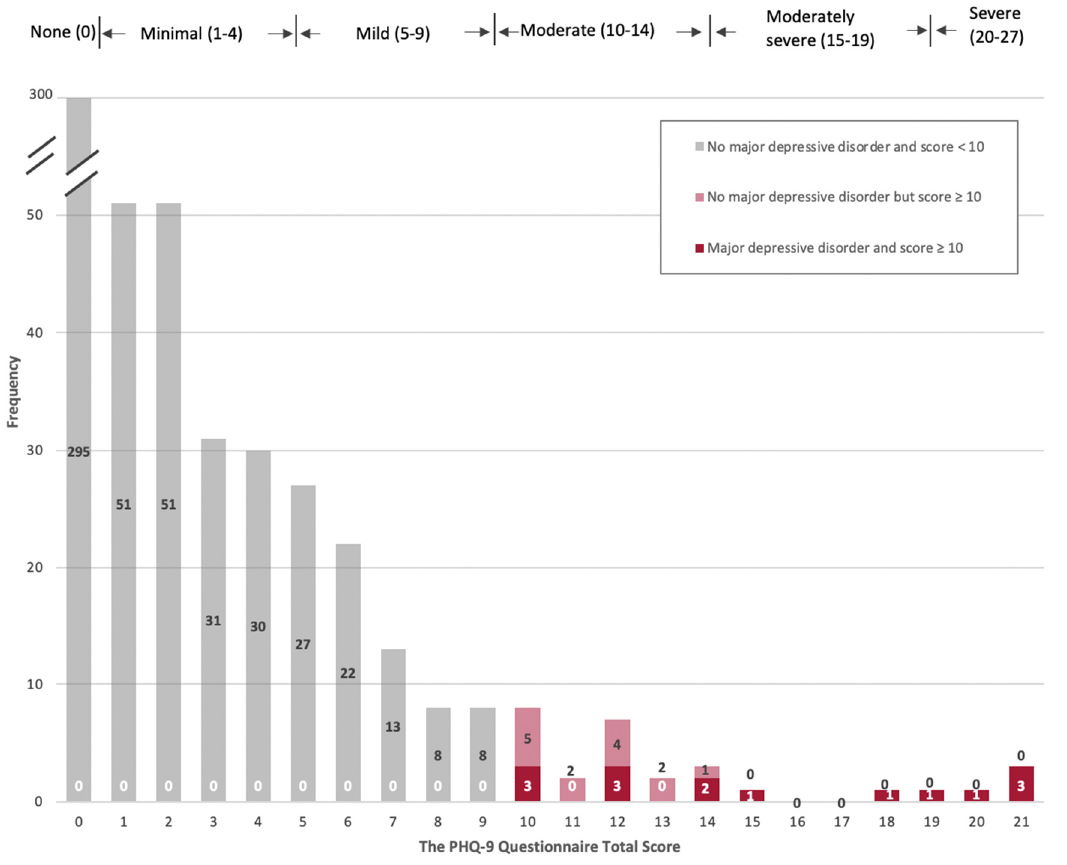
Figure 3. Frequency distribution of the PHQ-9 Depression Score and Major Depressive Disorder (N = 565). The histogram presents the distribution of the total scores of PHQ-9 questionnaires for a subsample of 565 women who participated in the second wave (2017) and third wave (2018) follow-up surveys of the family planning study in Malawi, completed the PHQ-9 questionnaire, and had no missing values on the covariates. Individuals who were diagnosed with major depressive disorder all scored above 10 points, but not vice versa. Table 2. Chi ‐ Square Test for Trend (One ‐ Way ANOVA).